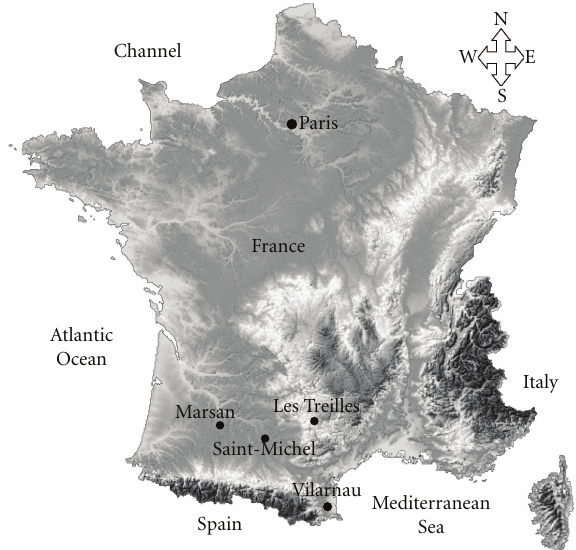
Figure 1: Topographic distribution of the four archaeological sites in southwest